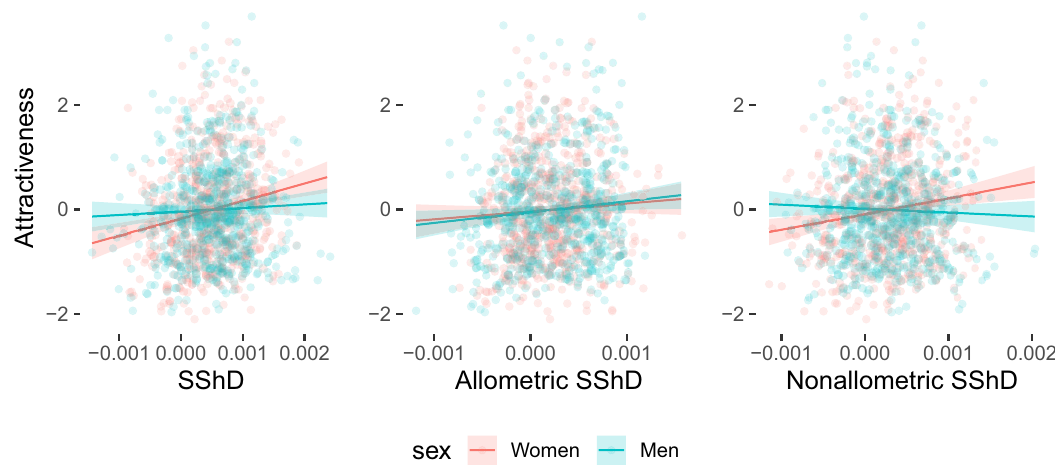
Figure 7. The relationship between overall, allometric, and non-allometric sexual shape dimorphism (SShD) and rated facial